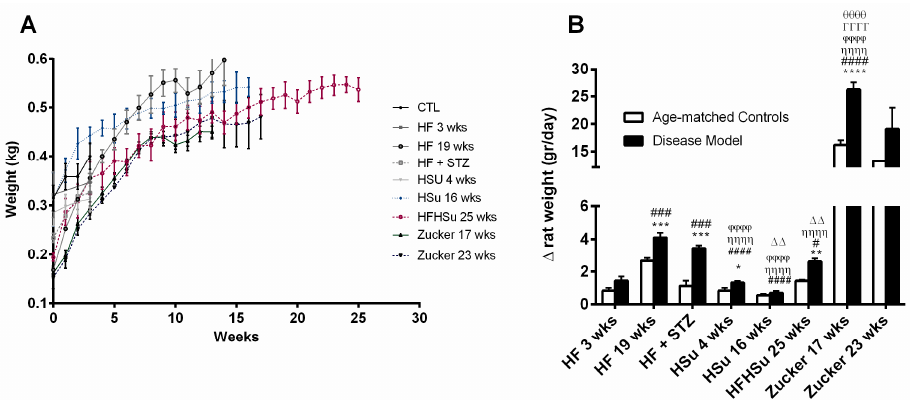
Figure 1. Weight gain in animal models of type 2 diabetes and obesity. ( A ) Growth curves. ( B ) Weight increase in animal groups expressed as g / day. All groups of hypercaloric diet animals and their aged-matched controls as well as Zucker diabetic rat and its lean controls of 17 weeks included 6–8 animals per group; Zucker diabetic rat of 23 weeks included 3 animals per group, and its lean control only one animal. Bars represent means ± SEM. Two-way ANOVA with Bonferroni’s multiple comparisons test: * p < 0.05, ** p < 0.01, *** p < 0.001, and **** p < 0.0001 comparing age-matched controls with disease models; # p < 0.05, ### p < 0.001, and #### p < 0.0001 comparing HF3 weeks with HF19 weeks, HF + STZ, HSu 4 weeks, HSu 4 weeks, HFHSu 25 weeks, and Zucker 17 weeks, respectively; ηηηηη p < 0.0001 comparing HF19 weeks with HSu 4 weeks, HSu 16 weeks, HFHSu 25 weeks, and Zucker 17 weeks; ϕϕϕϕ p < 0.0001 comparing HF + STZ with HSu 4 weeks, HSu 16 weeks, and Zucker 17 weeks; ∆∆ p < 0.01 comparing HSu 4 weeks with HSu 16 weeks and Zucker 17 weeks; θθθθ p < 0.0001 comparing HFHSu 25 weeks with Zucker 17 weeks; ΓΓΓΓ p < 0.0001 comparing HSu 16 weeks with Zucker 17 weeks.